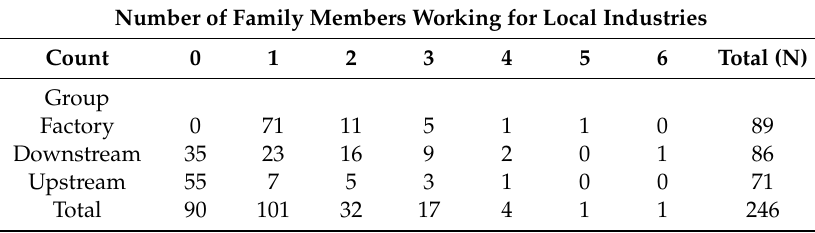
Table 2. Number of people working in local industries per family in di ff erent